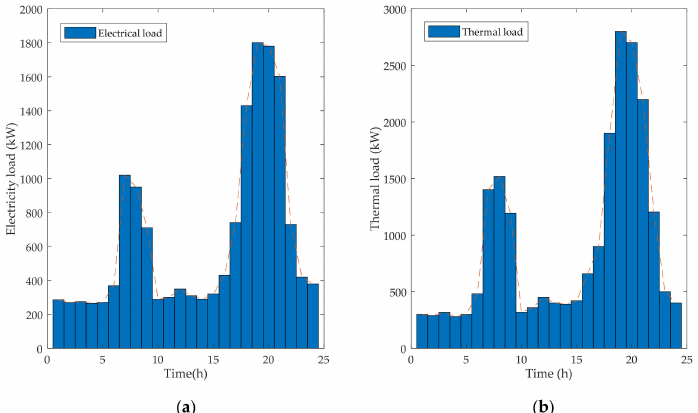
Figure 14. Energy consumption load in Case 2: ( a ) electrical load, ( b ) thermal